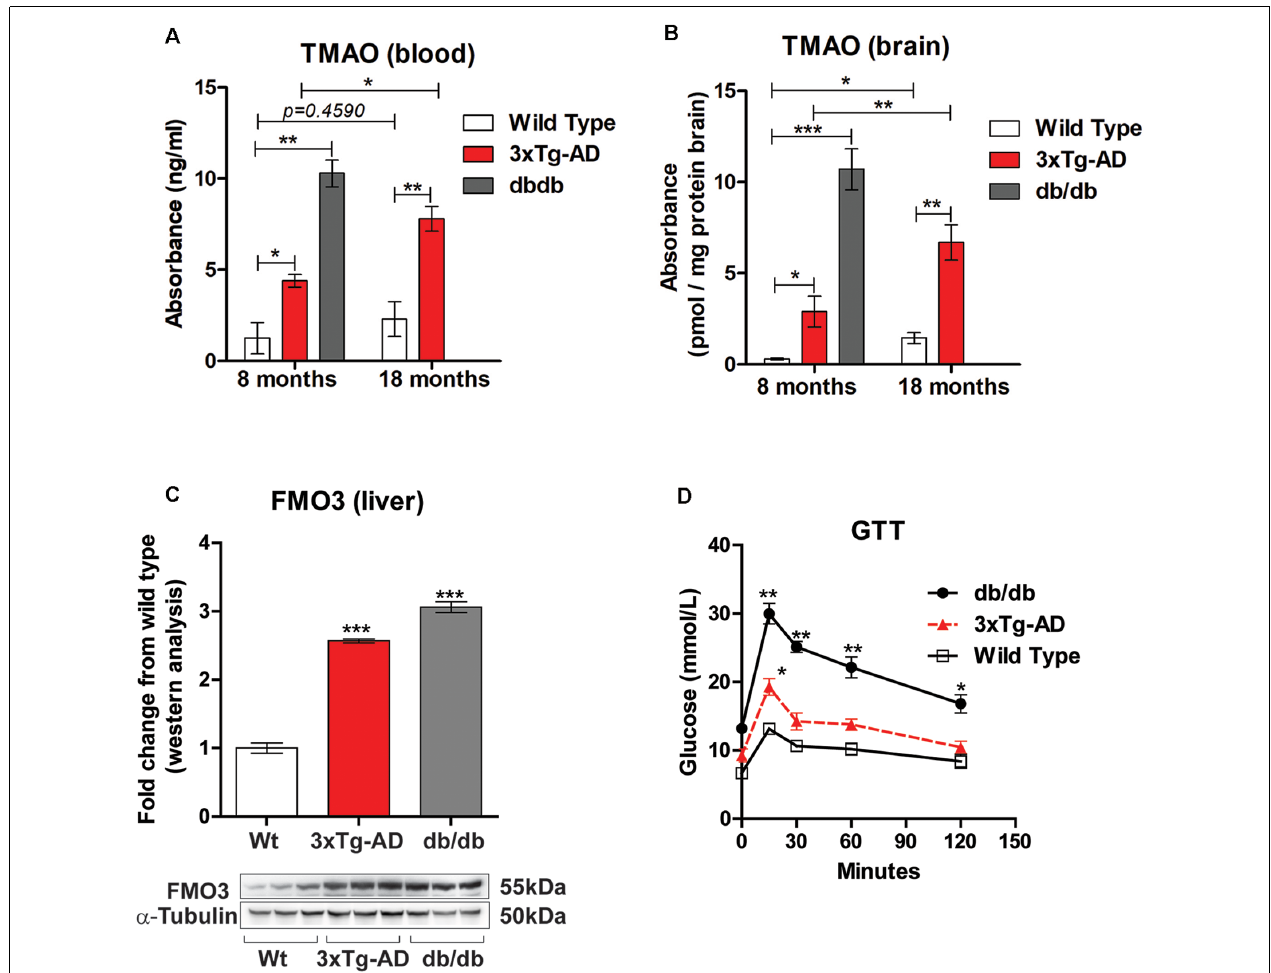
FIGURE 1 | Trimethylamine N-oxide (TMAO) is increased in 3 × Tg-AD and db/db mice. TMAO concentrations in the blood (A) and brain (B) in control, 3 × Tg-AD, and db/db mice at 8 months and 18 months. (C) Western blot analysis of FMO3 in liver lysates from control, 3 × Tg-AD, and db/db mice aged 8 months. α -tubulin was used as an internal housekeeping protein control. (D) Eight-month-old Control, 3 × Tg-AD, and db/db mice were subjected to glucose tolerance test (GTT) by intraperitoneal glucose administration (2.0 g.kg-1 of body weight). Blood was sampled at 0 (baseline), 30, 60, 90, and 120 min for glucose. Changes in serum glucose levels during the GTT relative to basal glycemic levels. Results are shown as mean ± SEM of three mice per group and * p < 0.05, ** p < 0.01 and *** p < 0.001 as compared to different groups.